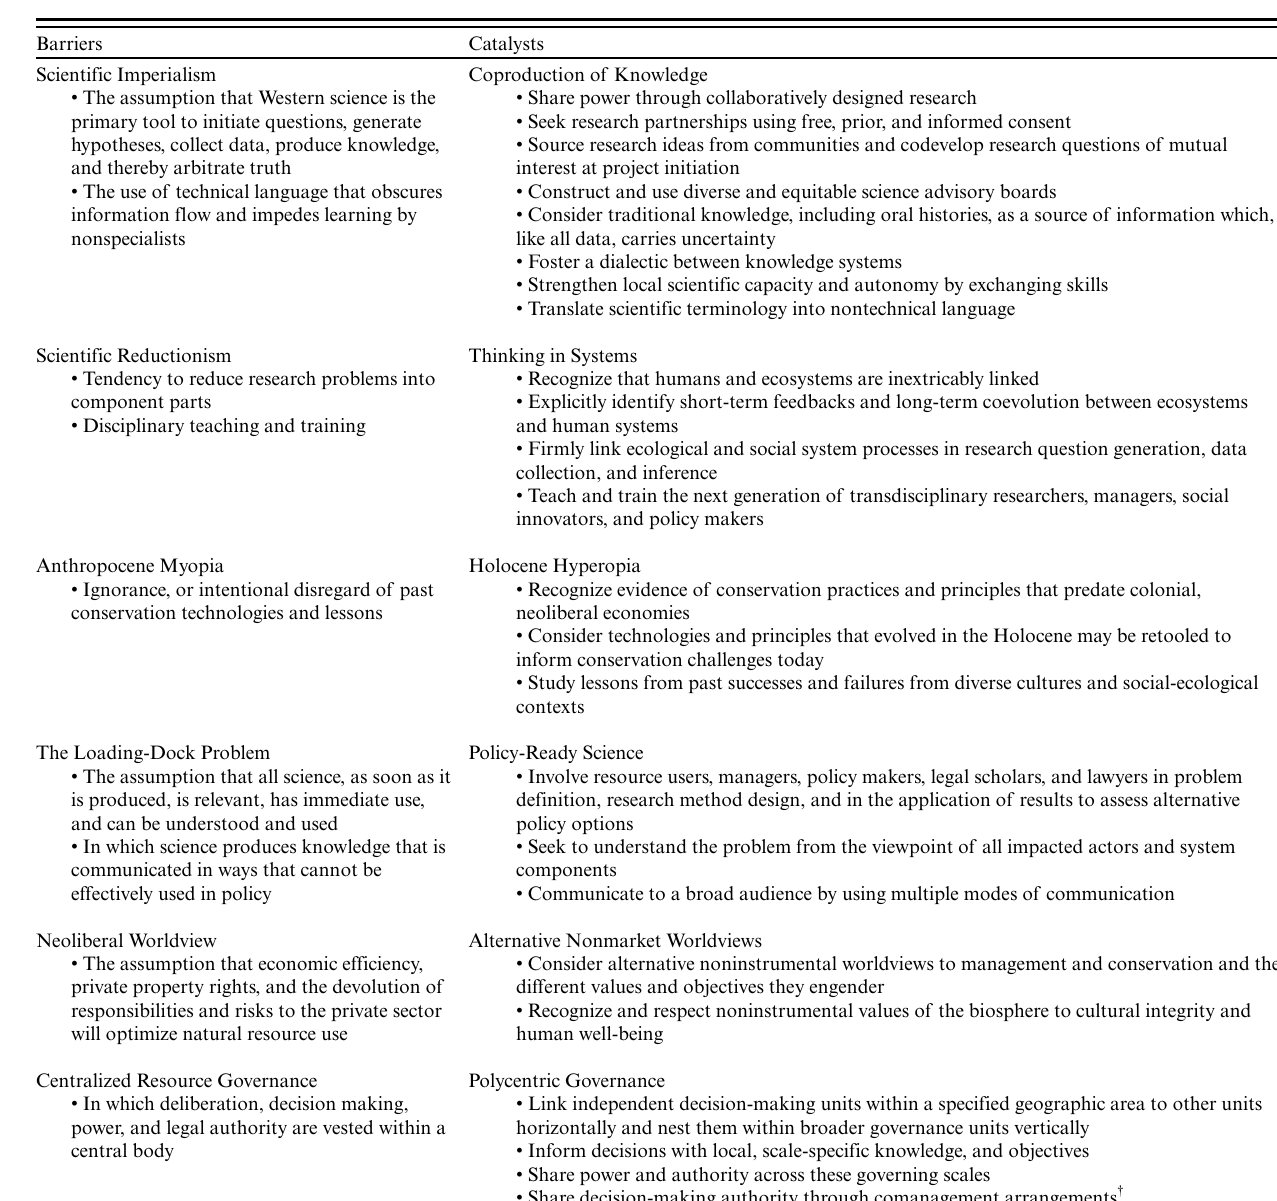
Table 2 . Barriers and catalysts to the democratization of conservation science and